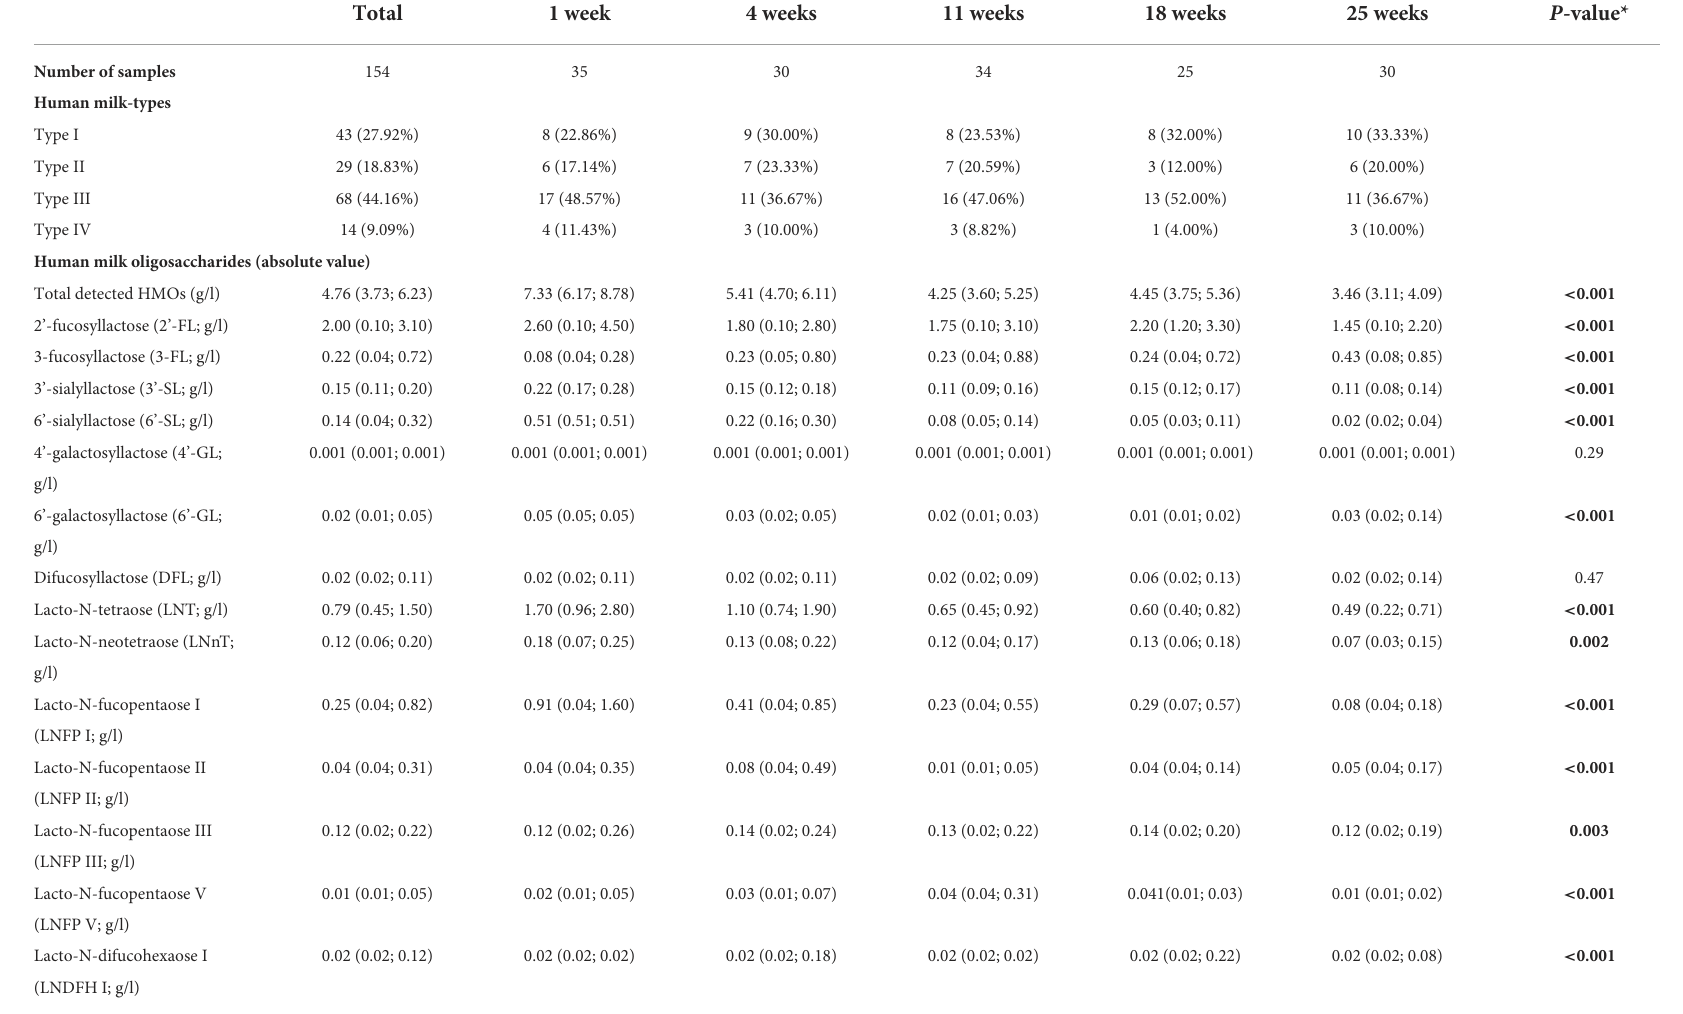
TABLE 2 Human milk-types and HMO content during